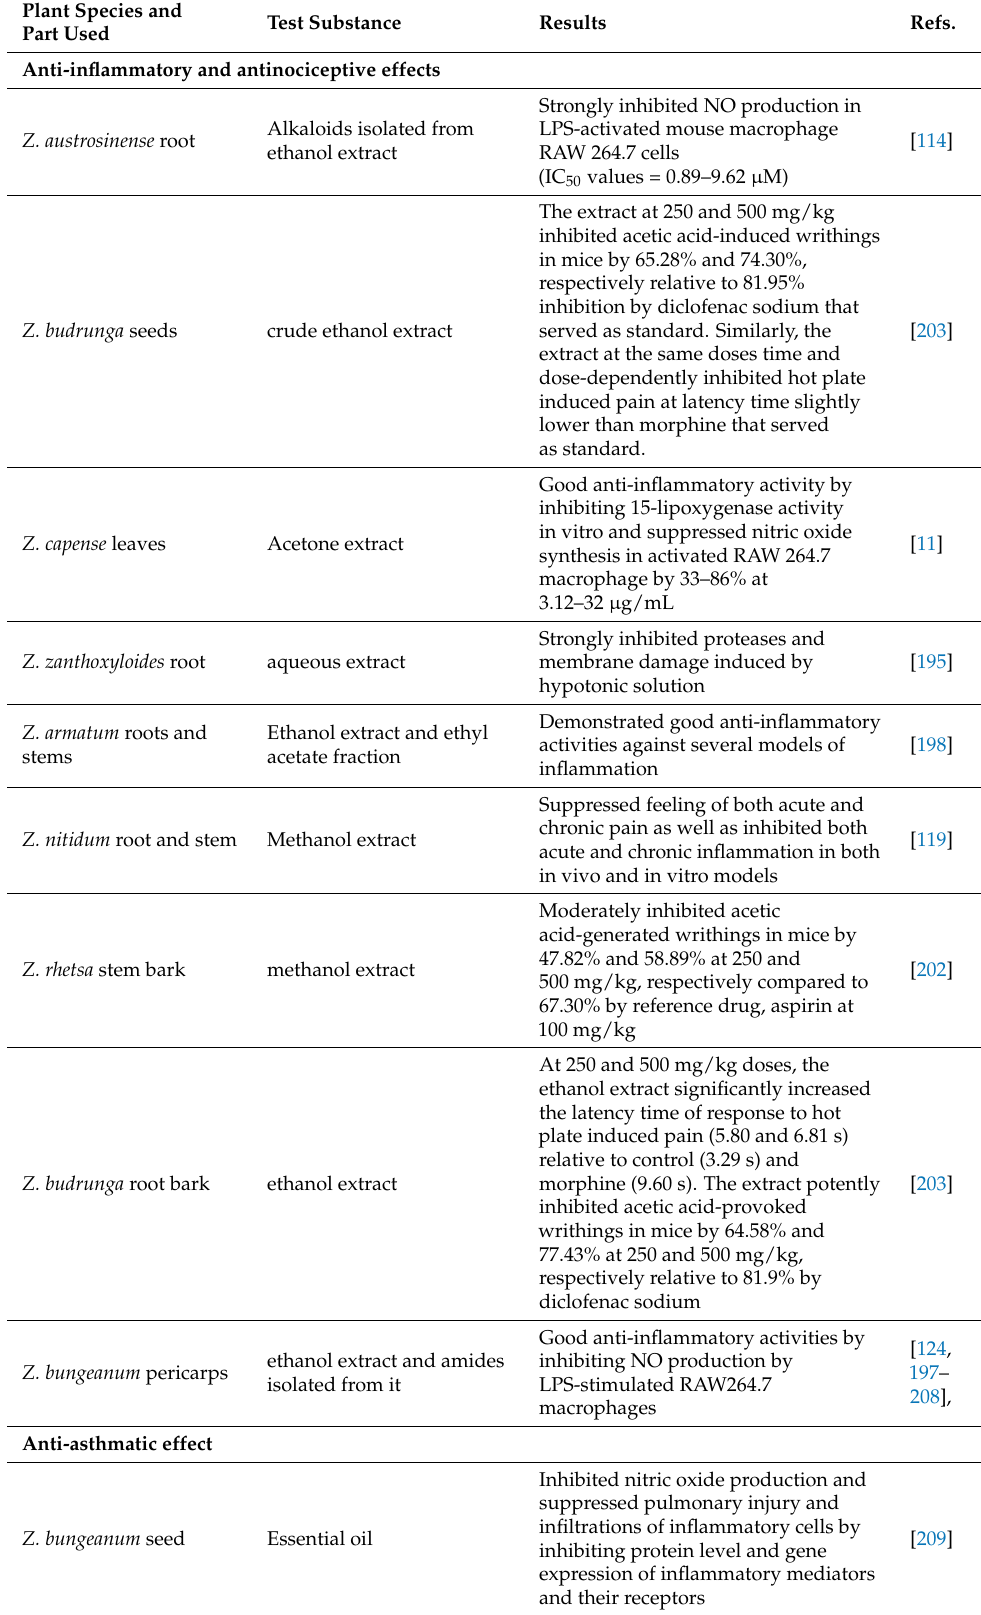
Table 10. Cont. Plant Species and Part